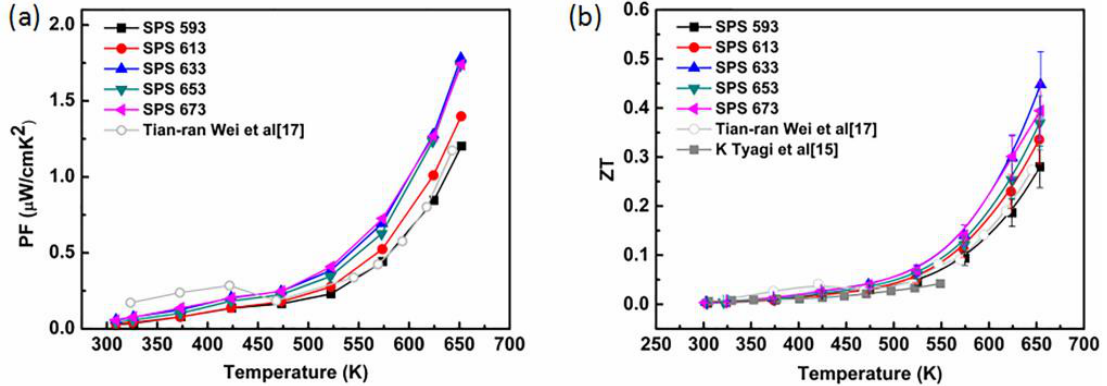
Figure 6. ( a ) Power factor and ( b ) ZT as functions of temperature of the samples with different SPS temperature.